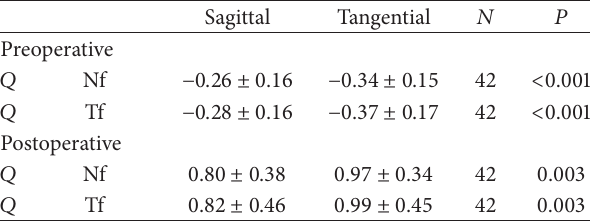
Table 1: Pre- and Postoperative values for asphericity ( 𝑄 ) in the flat principal semimeridians calculated by sagittal and tangential radius of curvature for the right eyes.